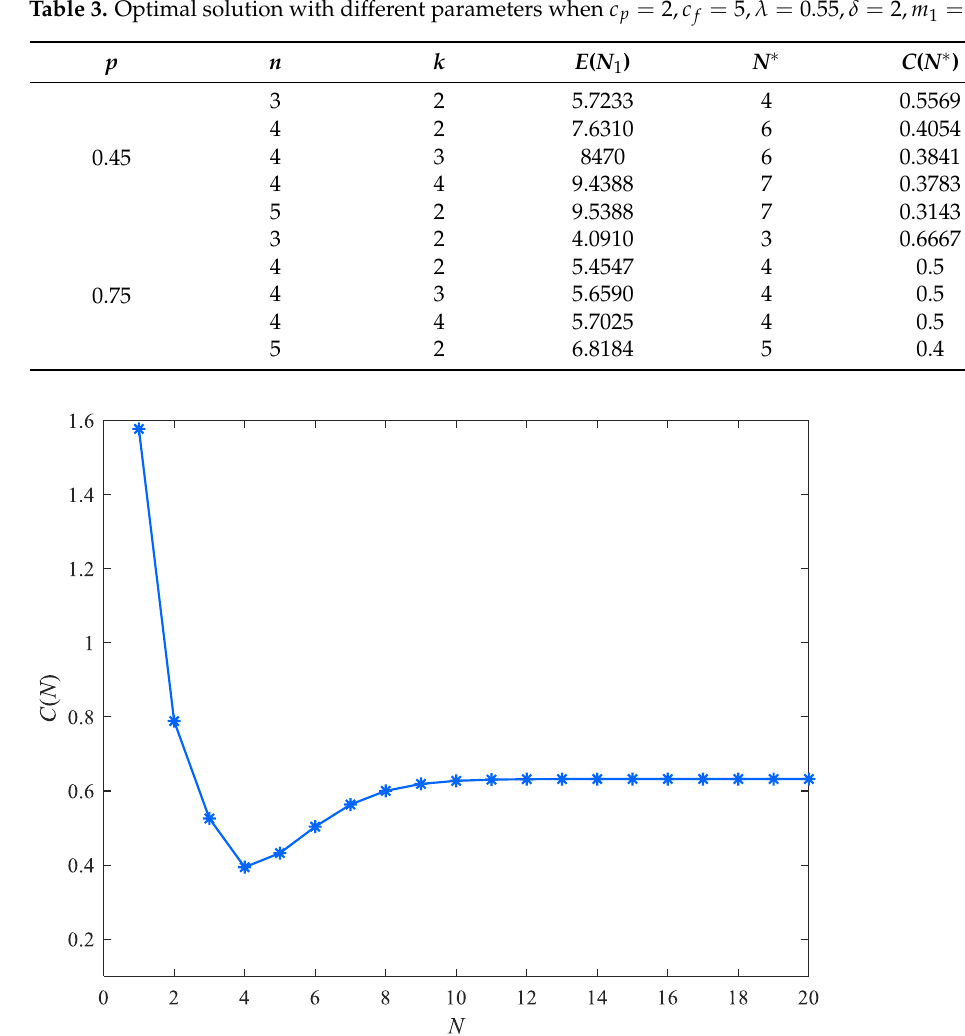
Figure 7. Cost under maintenance policy 1.